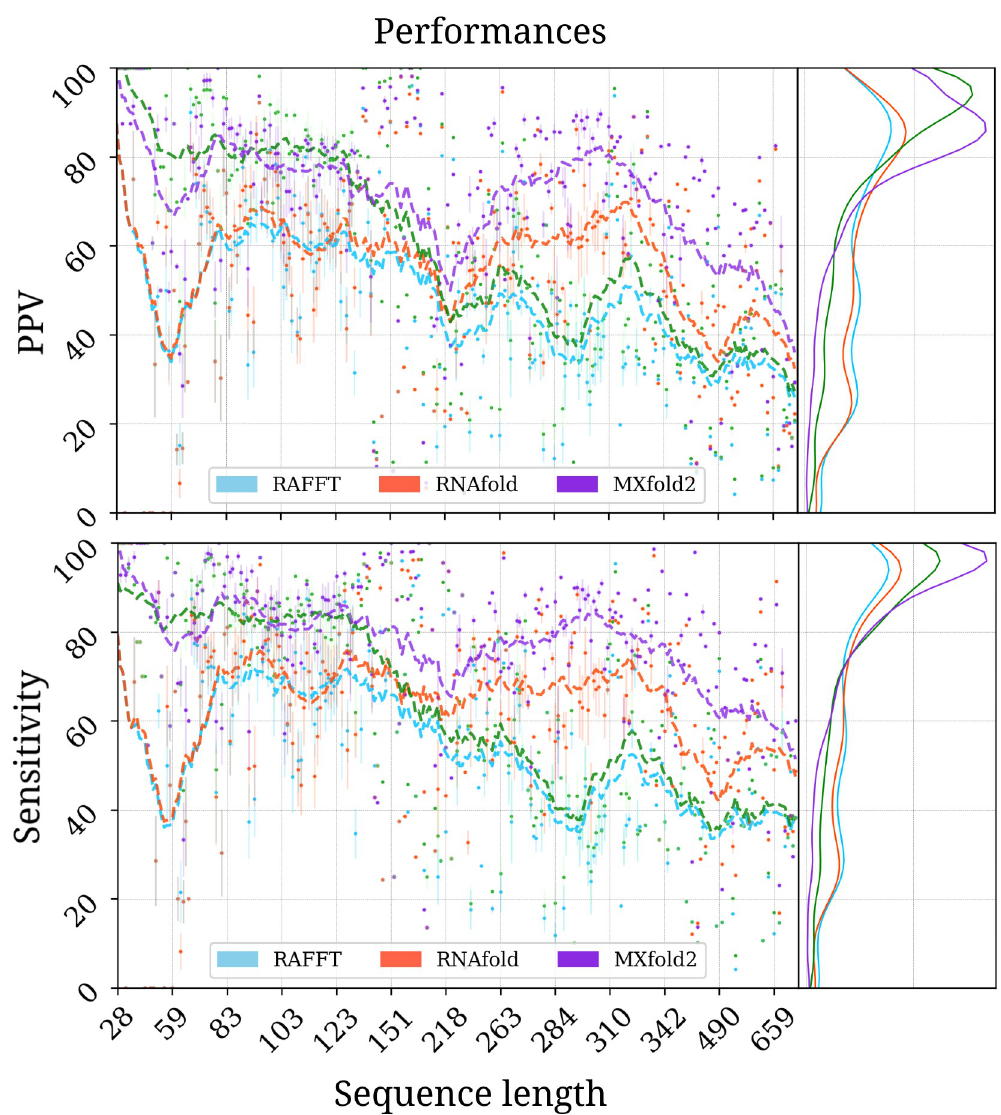
Fig 5. RAFFT ’s performance on folding task. PPV and sensitivity vs sequence length. In the left panels, RAFFT (in blue) shows the scores when for the structure (out of N = 50 predictions) with the lowest free energy, whereas RAFFT � (in green) shows the best PPV score in that ensemble. Each dot corresponds to the mean performance for a given sequence length, and vertical lines display their standard deviation. The right panels of both figures show the distribution of PPV and sensitivity